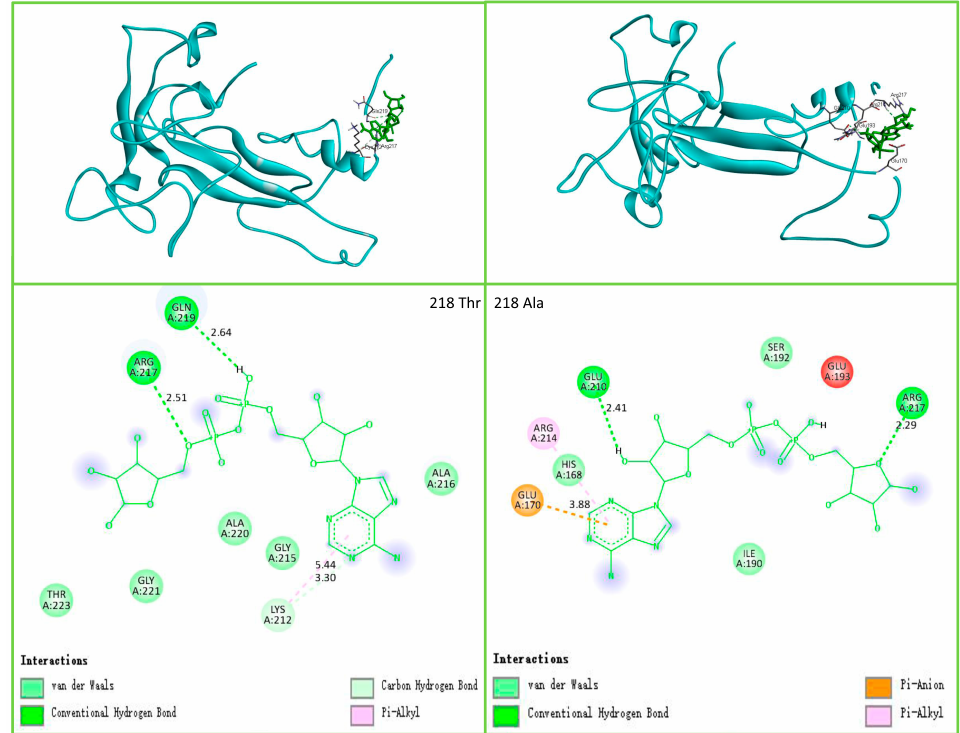
Figure 5. SNP11 affects NUDT9 molecular docking. SNP11 does not affect the structure of the NUDT9 protein. To display the docking of amino acids, different angles were rotated. The left side shows 218 Thr combined with ADPR. The right side shows 218 Ala combined with ADPR. The combination box has